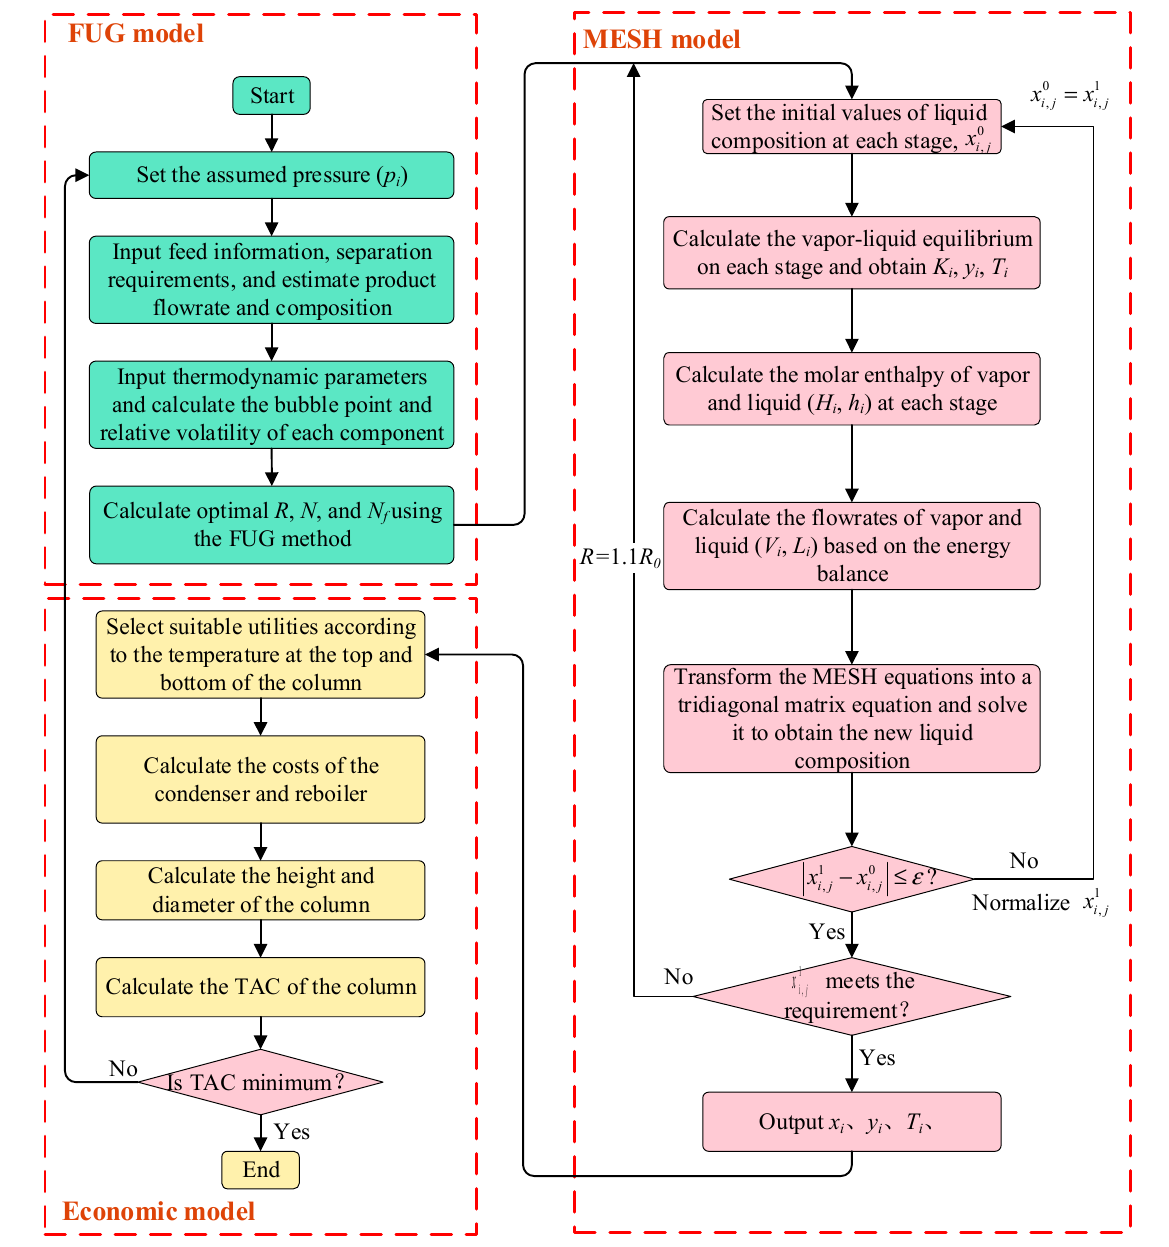
Figure 3. Optimization steps of a column.